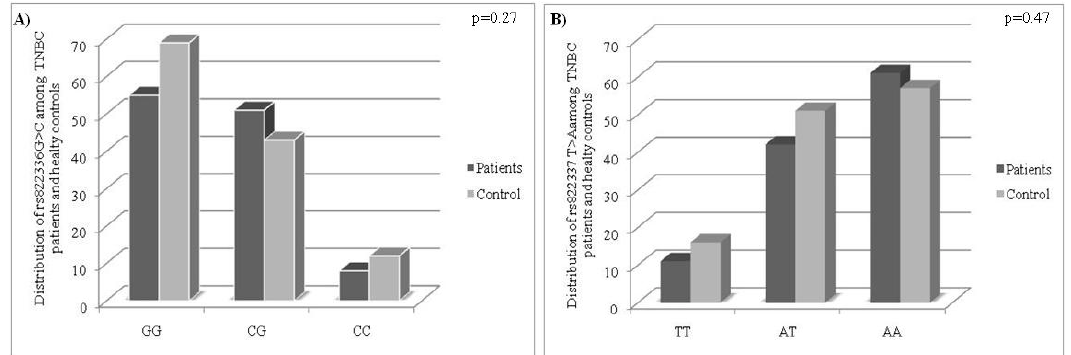
Figure 1. Distribution of the GG/CG/CC (rs822336 G>C) ( A ) and AA/AT/TT (rs822337 Τ > Α ) ( B ) alleles among TNBC patients and healthy controls.